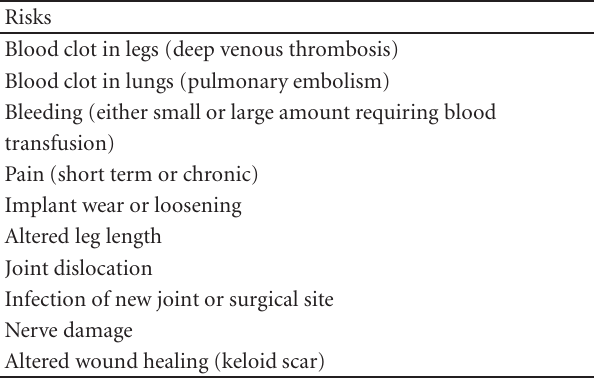
Table 1: Risks associated with knee or hip arthroplasty